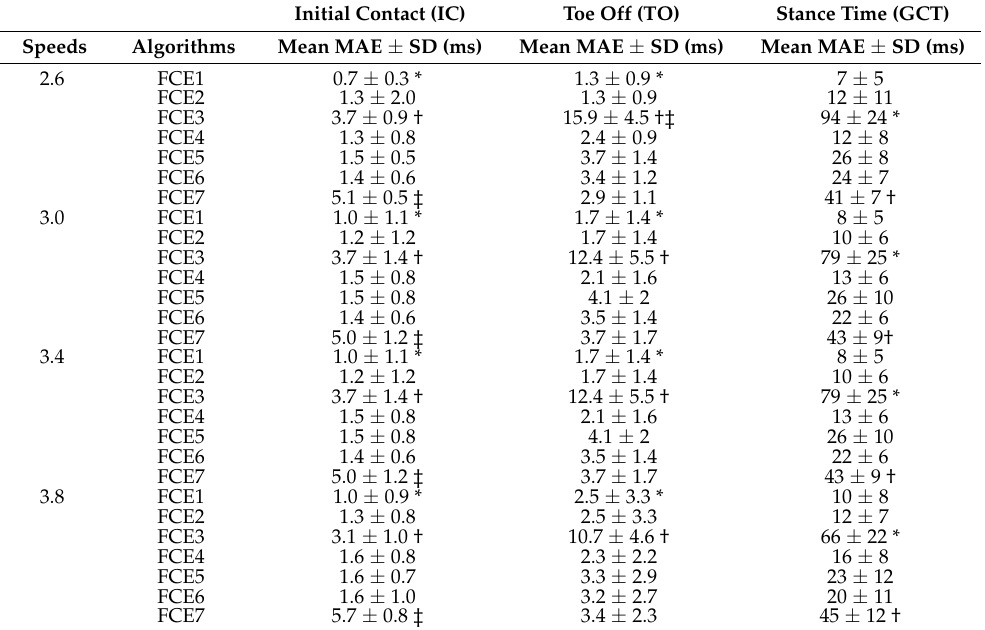
Table 1. Mean and standard deviations of the MAE (ms) for IC, FO, and GCT determined for each algorithm across all speeds (2.6, 3.0, 3.4, and 3.8 m/s) on a level grade. Initial Contact (IC) Toe Off (TO) Stance Time (GCT) Speeds Algorithms Mean MAE ± SD